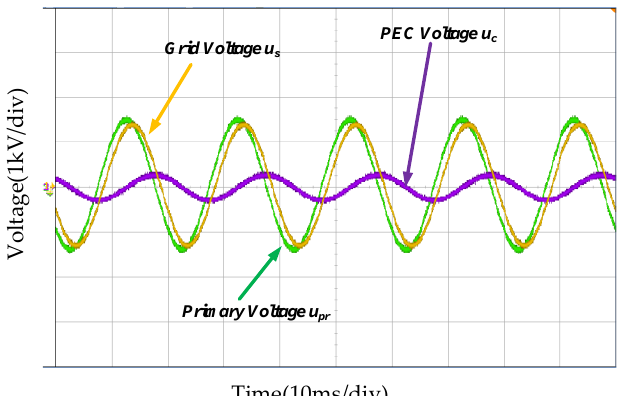
Figure 18. Waveforms of minimum vector reactive power compensation for flexible OLVR. In this way, the flexible OLVR could achieve load voltage regulation and realize the unit power factor operation of the grid side, as shown in Figure 19.